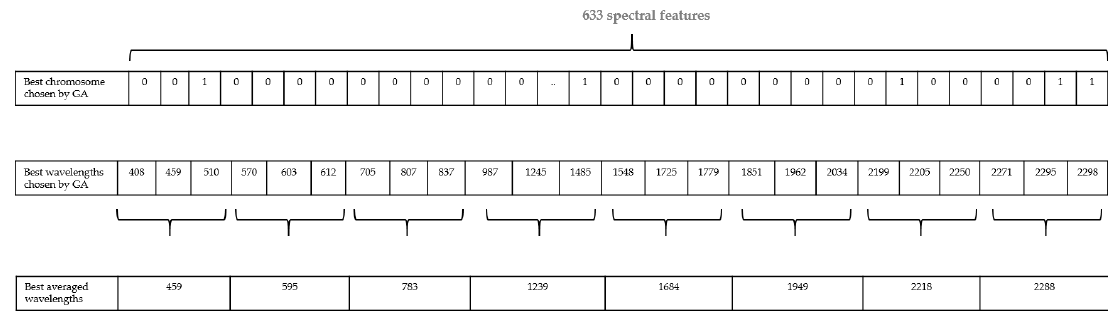
Figure 7. Example of feature averaging.